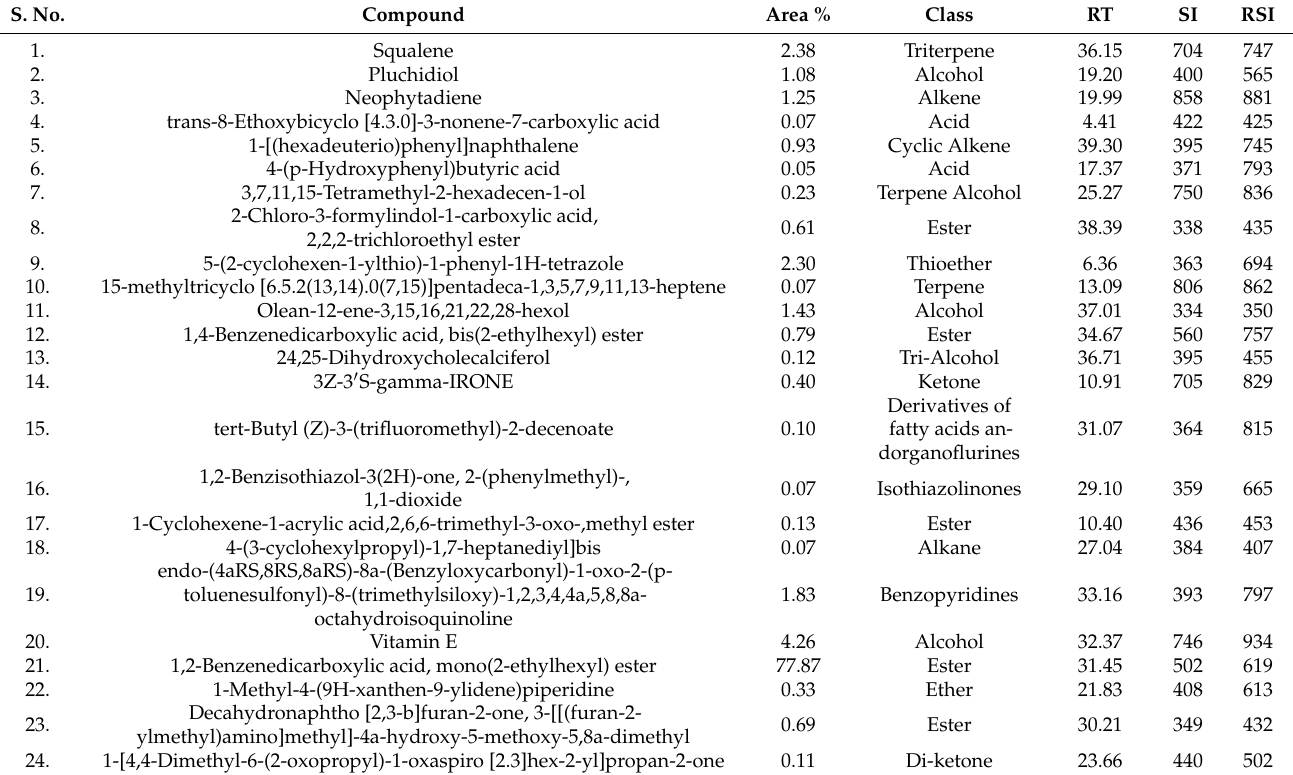
Table 2. GC-MS analysis of A. nitida fruit crude